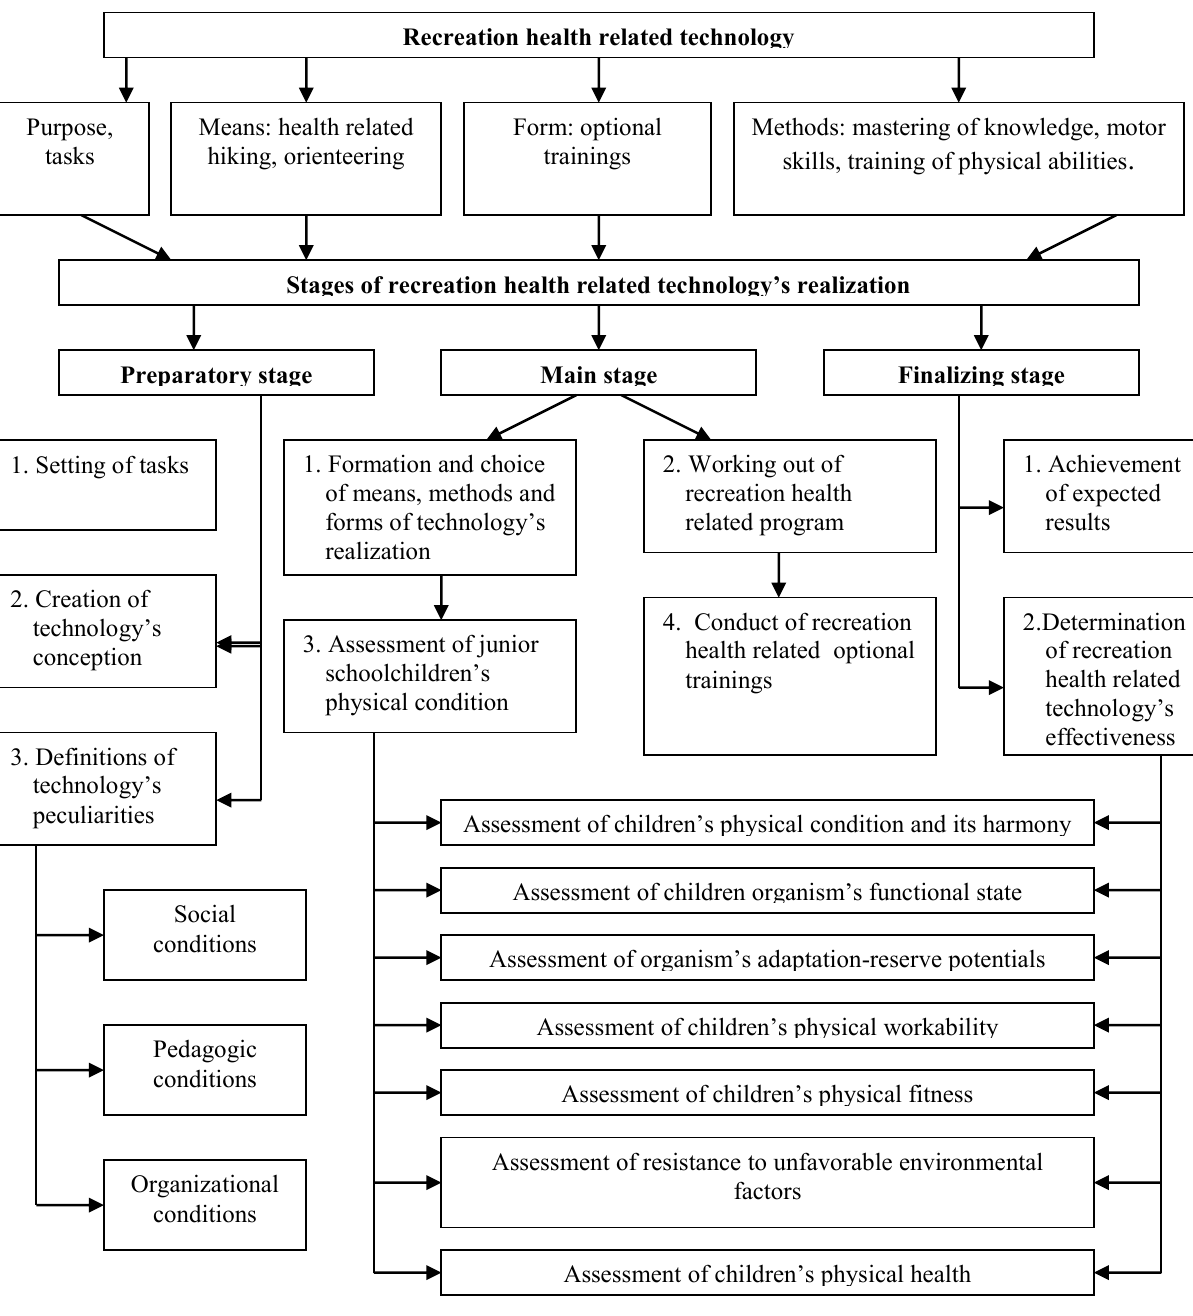
Fig.1. Block diagram, of structure of recreation health related technology’s